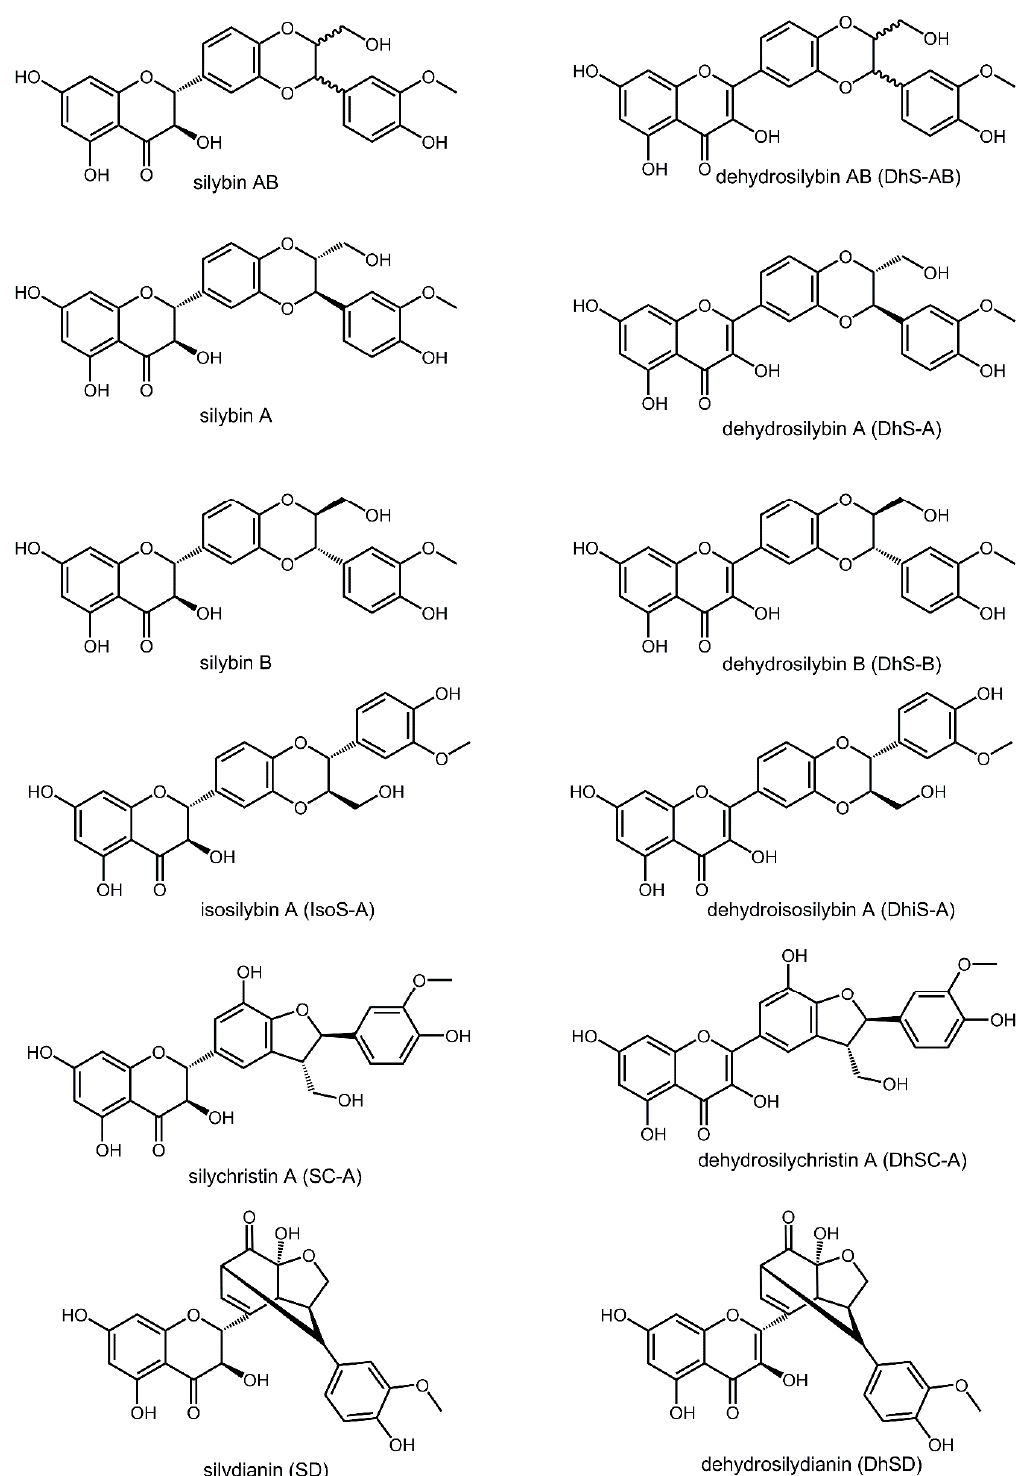
Figure 1. Chemical structures of flavonolignans from Silybum marianum (Milk thistle). Dose–response curves (DRCs) of the molecules displaying the higher activity on Li were performed. Cultures were exposed to doubling concentrations from 4.6 µ M to 600 µ M DhiS-A and DhS-AB; concentration range for DhSC-A and DhSD was from 3.75 µ M to 480 µ M. For comparative purposes, amphotericin B (AmB), paromomycin (PMM), Sb III and Sb V were included. Li and